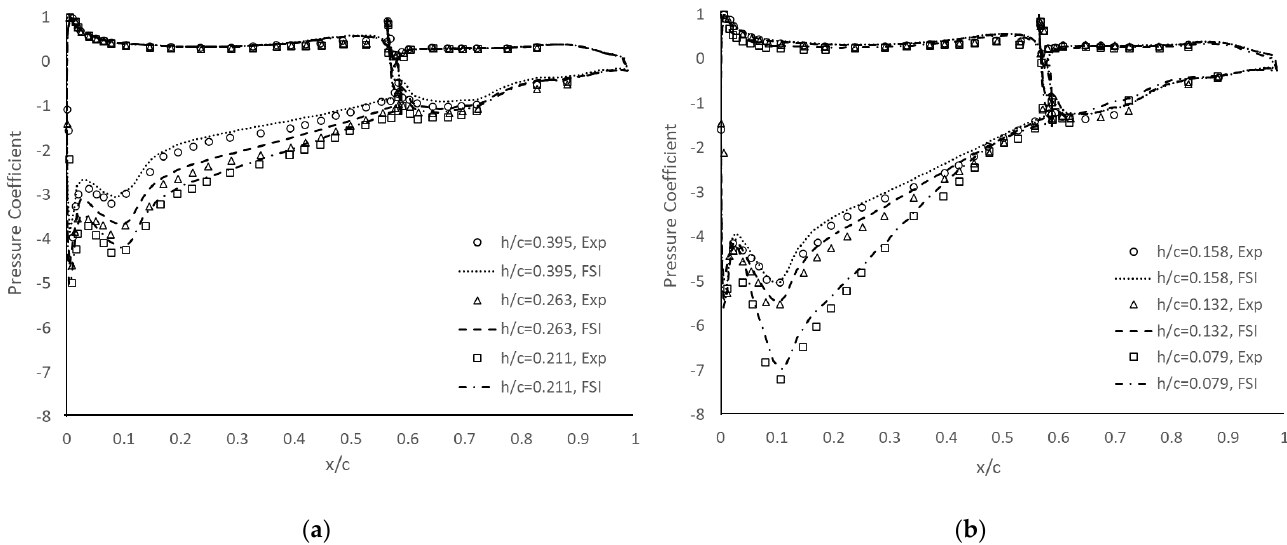
Figure 6. Chordwise surface pressure at wing centre: ( a ) high ride heights, ( b ) low ride heights.